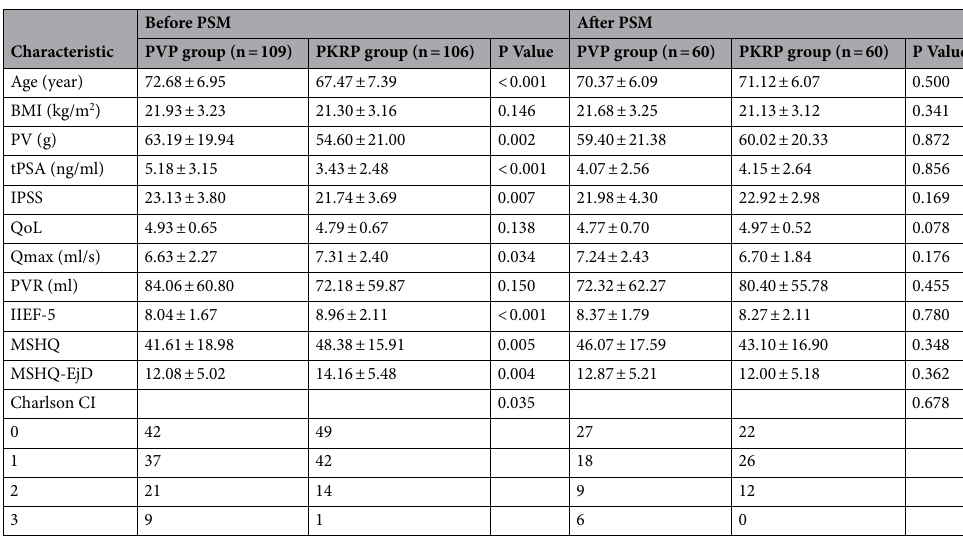
Table 1. Baseline patient characteristics. BMI body mass index, PV prostate volume, tPSA total prostate- specific antigen, IPSS international prostate symptom score, QoL quality of life score, Qmax maximal urinary flow rate, PVR postvoid residual, IIEF-5 international index of erectile function-five term score, MSHQ male sexual health questionnaire score, MSHQ-EjD male sexual health questionnaire on ejaculatory dysfunction score, Charlson CI charlson comorbidity